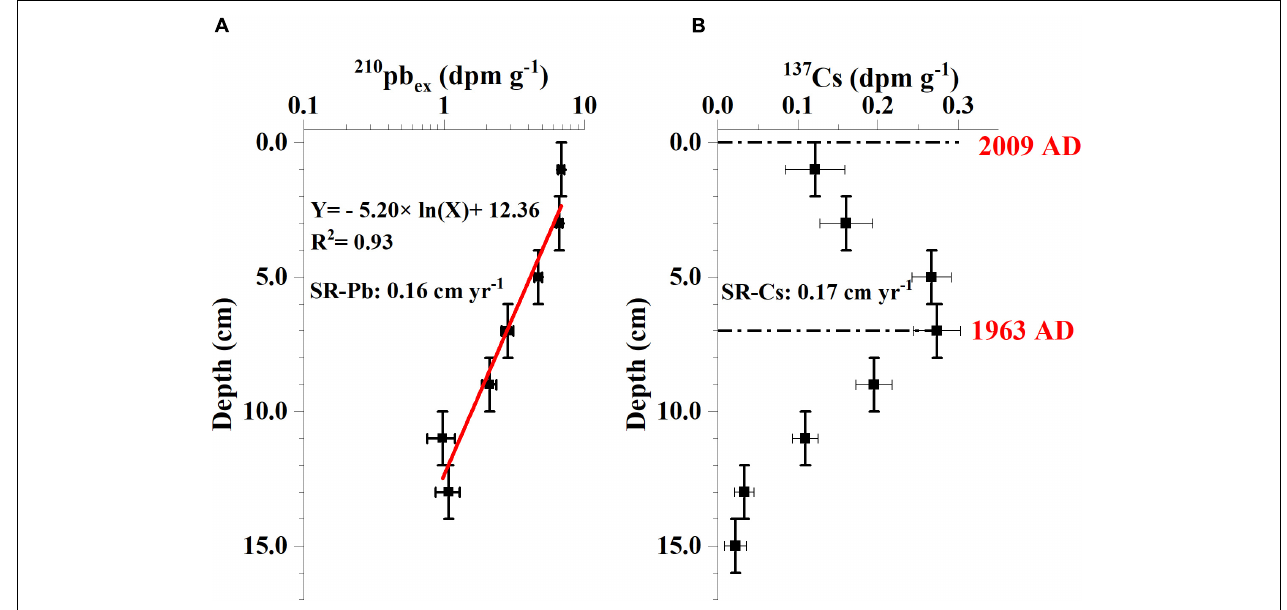
FIGURE 2 | (A) Downcore profiles of ln ( 210 Pb ex ) and (B) 137 Cs activities in core